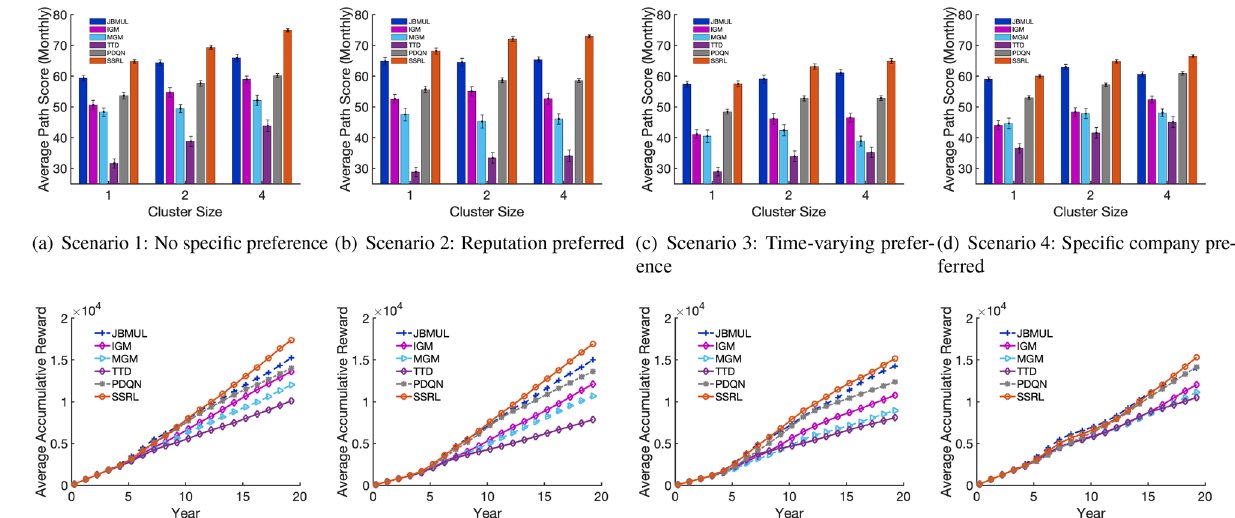
Figure 2. Average path score (per month) and accumulative reward. In this figure, ( a )–( d ) plot the average path scores (per month); ( e )–( h ) plot the accumulative rewards of recommended career paths over a 20-year career timeline ( company cluster size = 4 ). Four experimental scenarios are tested. In Scenario 1, we consider a general case where people have no specific preference (i.e., the weight set of company-related features [ reputation , popularity , average staying duration , smooth transfer rate ] is set to [0.25, 0.25, 0.25, 0.25]. Scenario 2 represents a case where users may have a specific preference on one of the features, e.g., the reputation. The weight is set to [0.7, 0.1, 0.1, 0.1]. Scenario 3 mimics a dynamic preference in someone’s career life. We assume someone has a specific preference on the company reputation in the first 10 years (the same as Scenario 2), then the weight is updated to [0.1, 0.1, 0.7, 0.1], representing a preference change. Scenario 4 demonstrates an extreme case that someone has a preference on specific companies at a specific time. For example, someone has a clear plan to join Bank of Boston (or similar companies) at the early stage in her career (e.g., we lock our recommendations to the preferred companies at the third decision point [around the sixth career year]). For each case, we simulate the path with 30 random initial states, and the mean values are then plotted along with their standard errors [the error bars in ( a )–( d